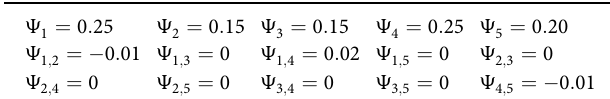
Möbius inverse of the